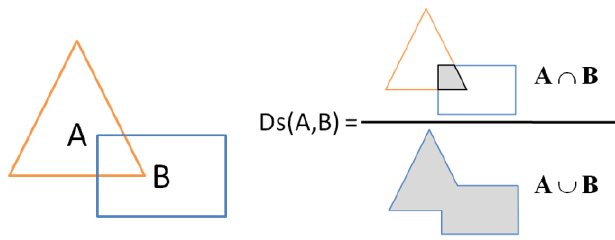
Figure 1. The surface distance to assess two polygons similarity, the ratio between the areas of the grey surfaces (the intersection of polygons A and B and their